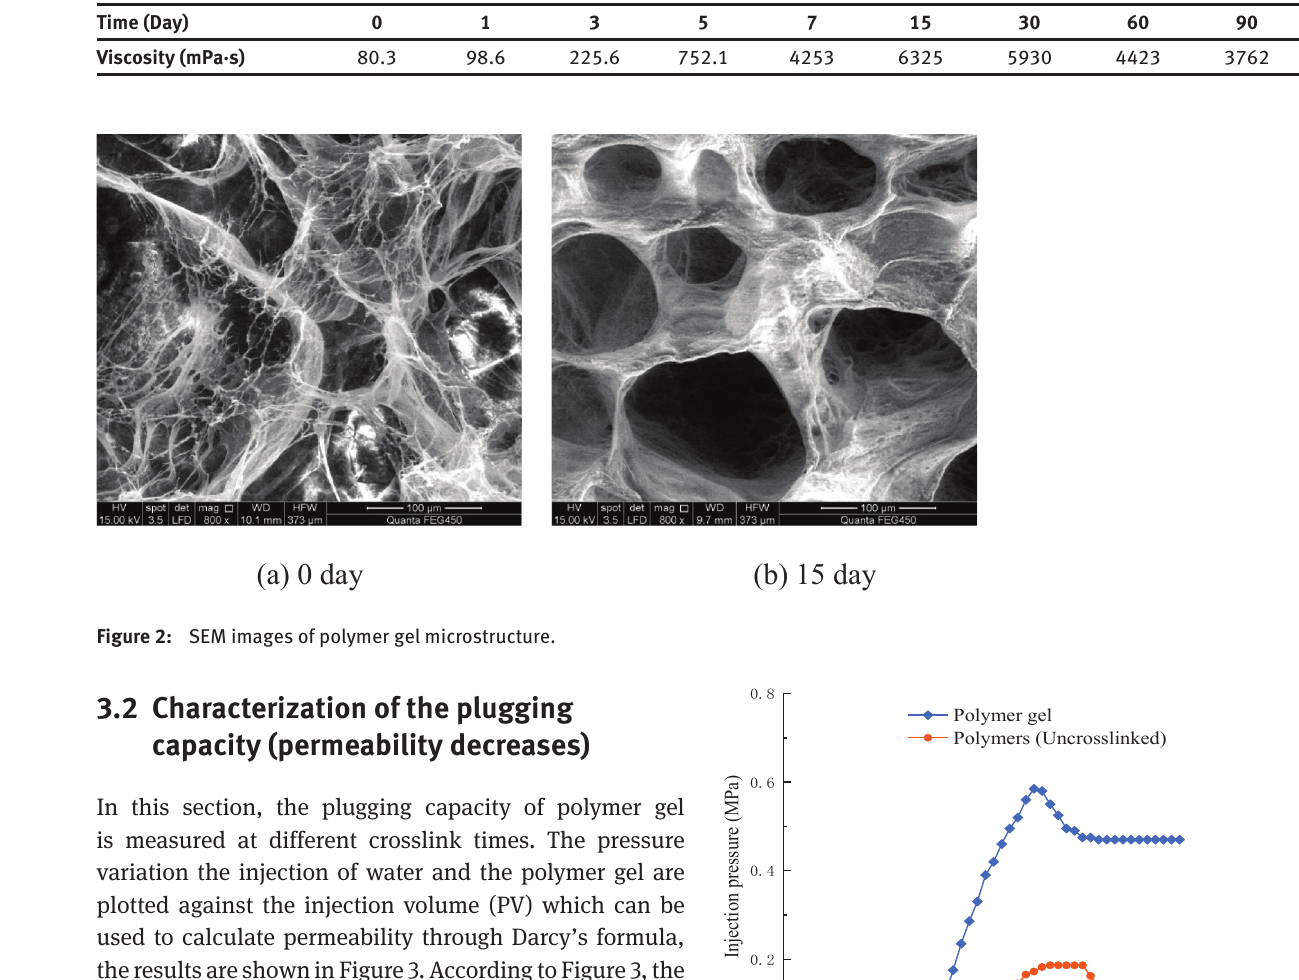
Table 2: Viscosity of polymer gel solution.